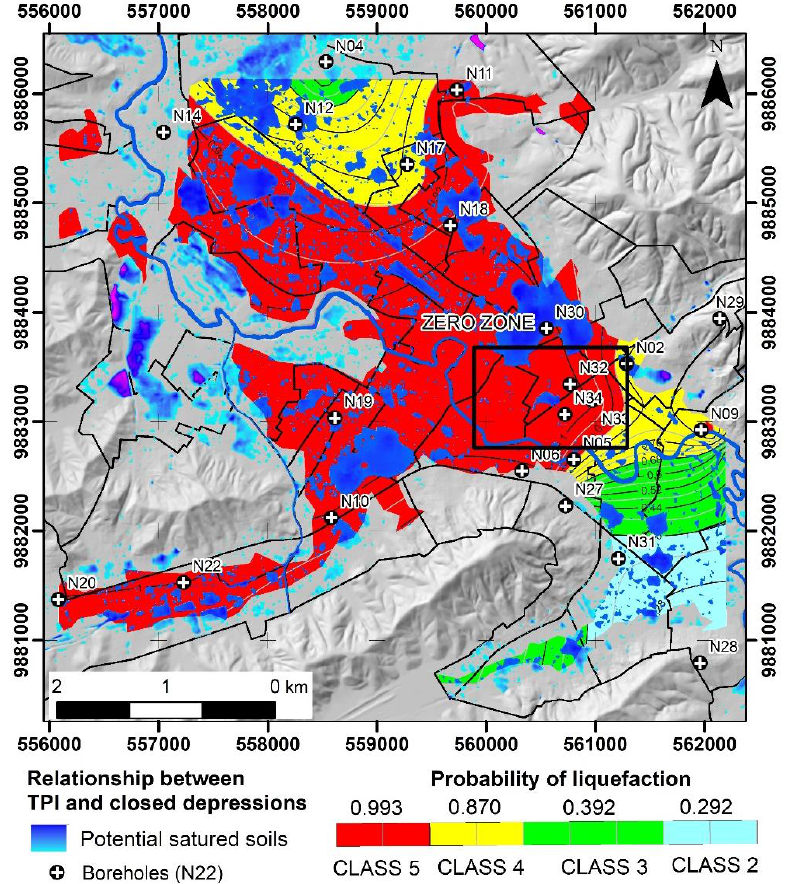
Figure 8. Liquefaction probability hazard map of the urban center of Portoviejo city. A seismic hazard scenario corresponding to a max = 0.50 g was used in the predicted probability of liquefaction occurrence, as adapted and modified from Cando-Jácome et al. [51].